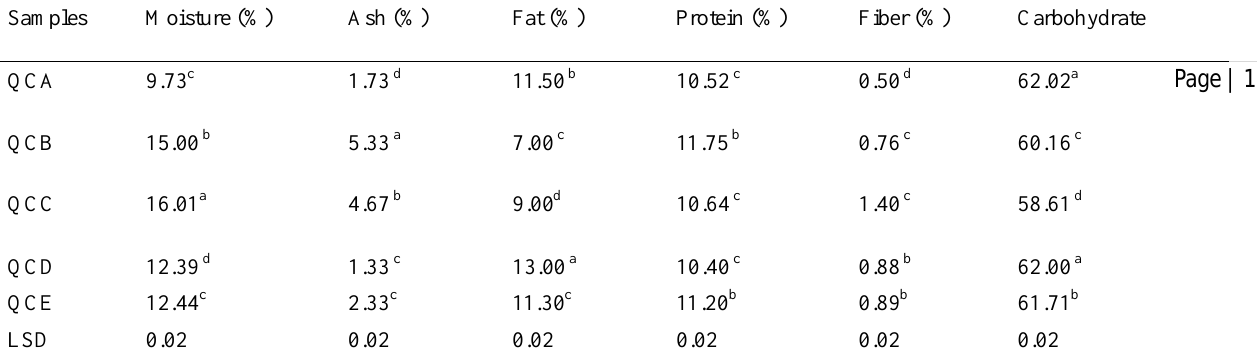
Table 1: Proximate composition of Queen Cakes samples Samples